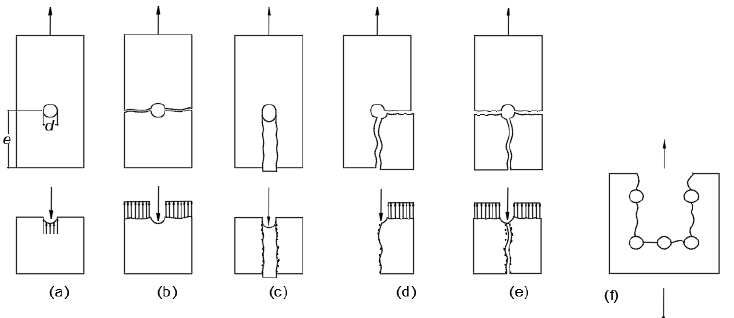
Figure 2. Failure mode of bolted connection and simplified stress distributions. ( a ) bearing, ( b ) net-tension, ( c ) shear-out, ( d ) cleavage, ( e ) net-tension ‘splitting’, and ( f ) block shear.